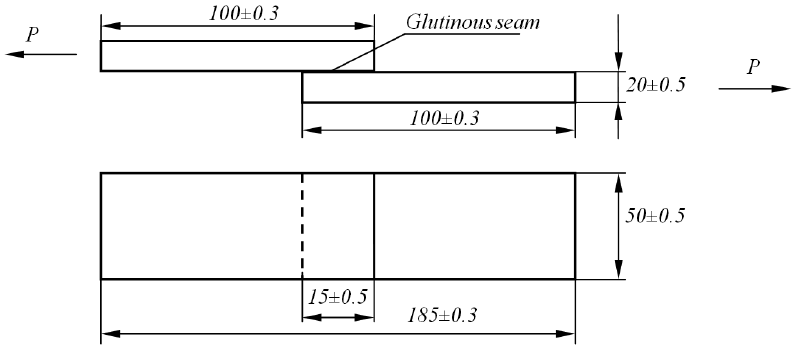
Figure 5. Scheme of gluing and testing samples for the tensile strength.